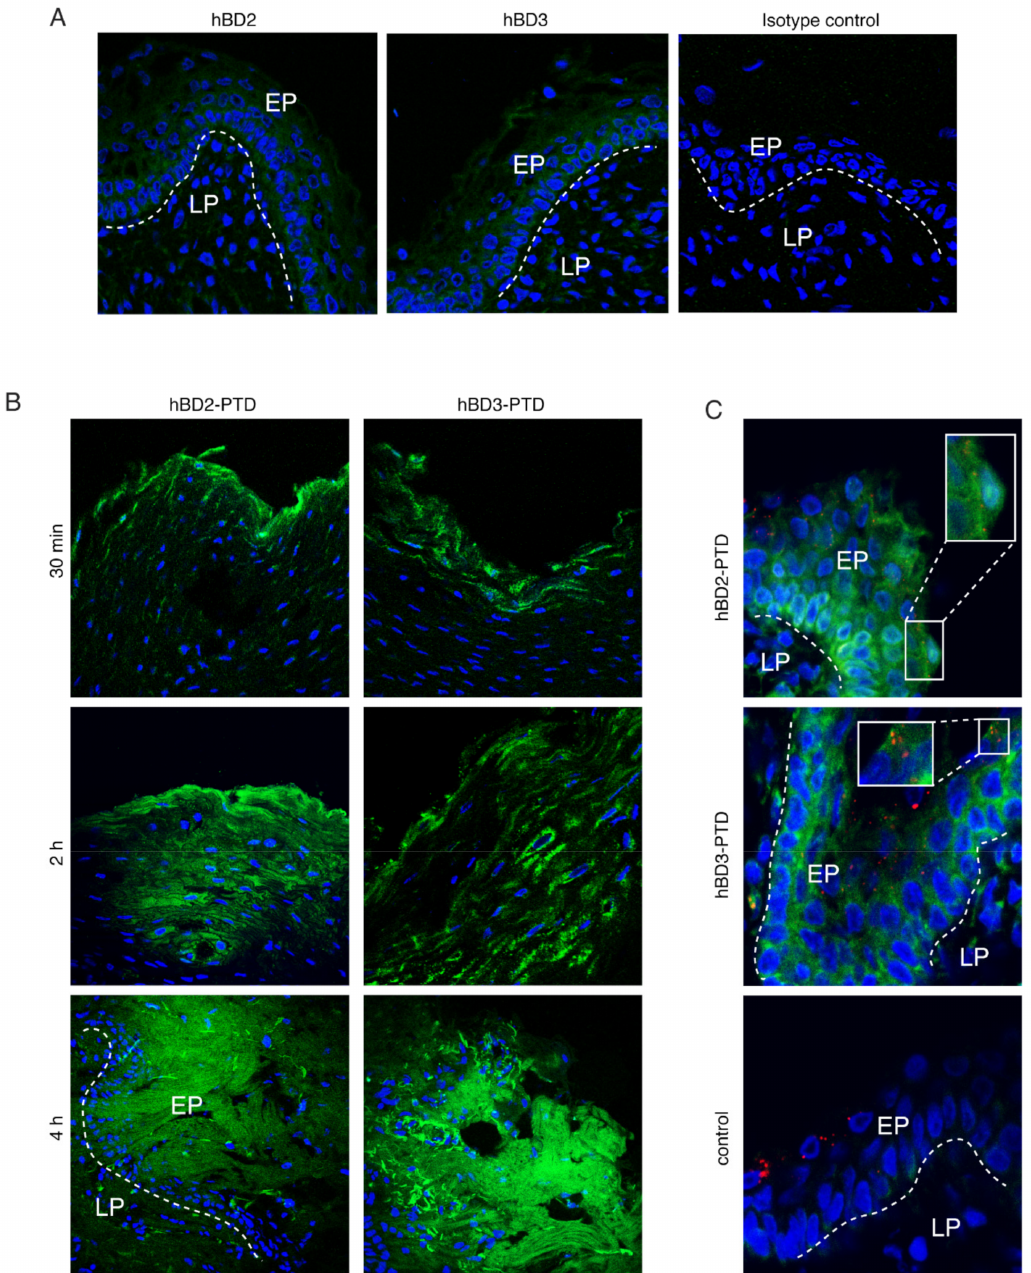
Figure 10. hBD-2 PTD and hBD-3 PTD internalization into ex vivo tonsil epithelial tissues. ( A ) Tonsil tissues were immunos- tained for hBD-2 and -3 (green). ( B ) Tonsil tissue explants were treated with hBD-2 PTD and hBD-3 PTD (100 µ g/mL each), and after 30 min, 2 h, and 4 h, explants were fixed and immunostained for hBD-2 and -3. ( C ) Tonsil tissue explants were exposed to HIV-1 SF33 (100 ng/mL) and after 4 h were treated with hBD-2 PTD and hBD-3 PTD for the next 4 h. Tissues were coimmunostained for HIV-1 p24 (red) and hBD-2 or -3 (green). In merged panels, yellow indicates colocalization of HIV-1 p24 with hBD-2 PTD and hBD-3 PTD . ( A through C ) Cells were analyzed by confocal microscopy. Cell nuclei were counterstained in blue. EP, epithelium; LP, lamina propria. Magnification: × 400. Similar data were obtained in two independent